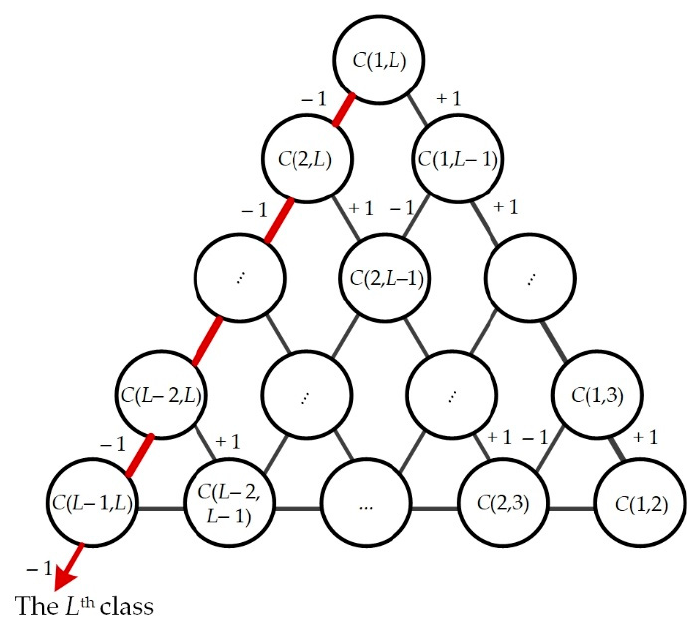
Figure 4. Directed acyclic graph (DAG) for classifying L classes with ( L − 1) binary classifiers.